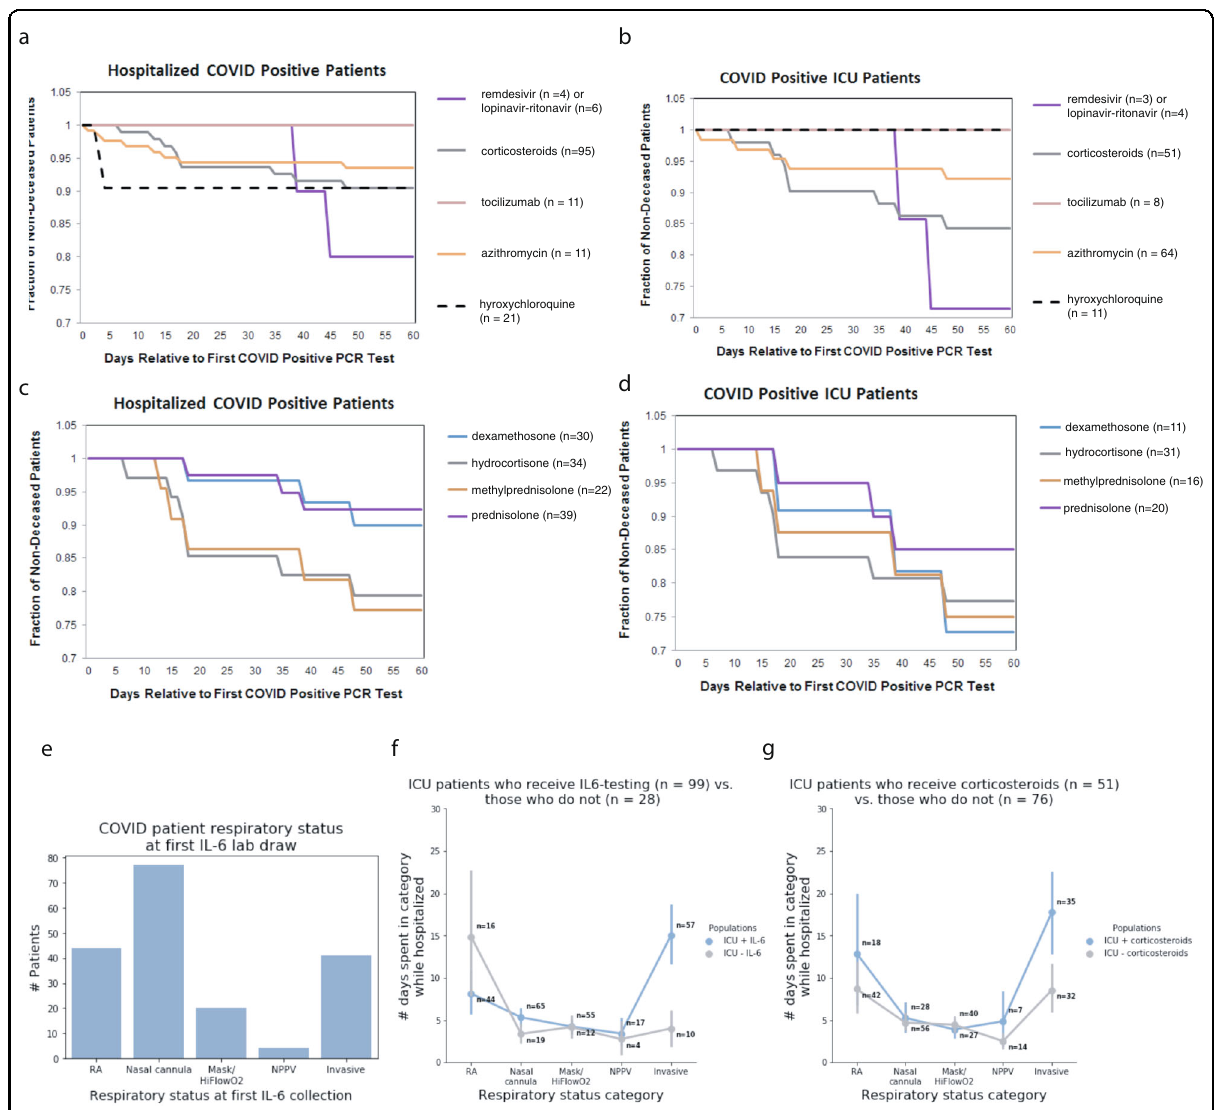
Fig. 8 Survival curves and respiratory status for the study cohort. Survival curves for ( a ) hospitalized and ( b ) ICU-COVID-19 patients who received corticosteroids, tocilizumab, azithromycin, hydroxychloroquine, or antivirals (remdesivir or lopinavir – ritonavir) following their SARS-CoV-2- positive PCR test. c Survival curves for each corticosteroid administered patient who is hospitalized, split up by the exact corticosteroid drug. d Survival curves for each corticosteroid administered patient who is in the ICU, split up by the exact corticosteroid drug, i.e., dexamethasone, hydrocortisone, methylprednisolone, or prednisone. e Bar plot of COVID-19 patient respiratory status at fi rst IL-6 lab draw, showing that ICU patients who receive IL-6 testing are typically initially tested early in the course of respiratory failure (panel A), ( f ) yet spend a long time in critical respiratory failure, indicating that physicians may be using IL-6 as part of their assessment of patients who are rapidly progressing towards critical respiratory failure. Here, RA indicates that the patient is breathing room air. The nasal cannula includes all nasal cannula with oxygen fl ow rates up to 15 L/min. Mask/HiFlowO 2 includes devices designed to increase the percentage of oxygen inspired with each breath, such as a non-rebreather, Oxymizer, OxyMask, high fl ow nasal cannula, etc. NPPV includes all forms of non-invasive positive pressure ventilation, such as CPAP (continuous positive airway pressure), BiPAP (bilevel positive airway pressure), and oxygen-supplemented CPAP/BiPAP. Invasive ventilation includes intubation and mechanical ventilation. g Across every respiratory status, COVID-19 patients who received corticosteroids generally are worse from a respiratory standpoint than patients who did not receive